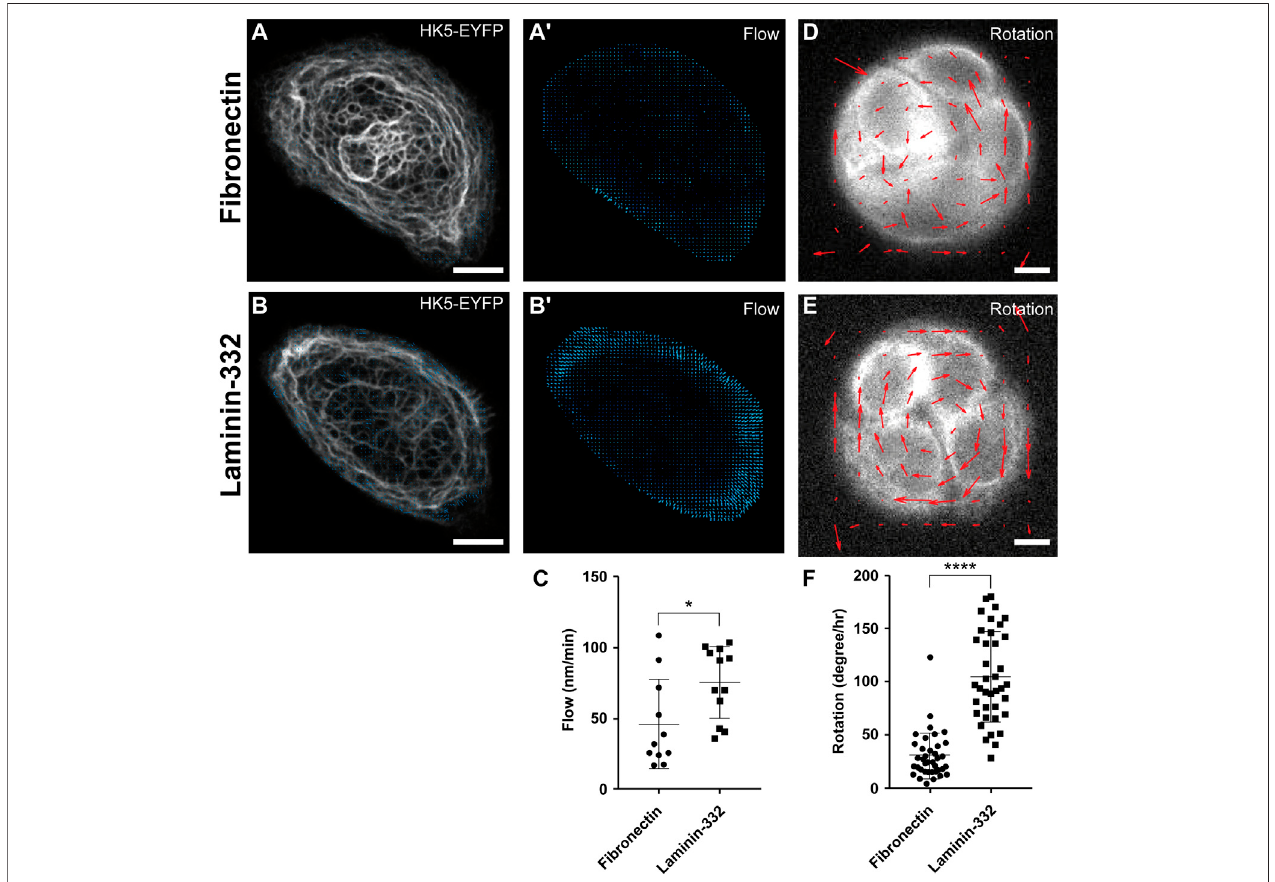
FIGURE 1 | Keratin fl ow and rotational migration of keratinocytes are dependent on ECM composition. (A,A ’ ,B,B ’ ) Show fl uorescence microscopy and corresponding keratin fl ow vectors of HaCaT B10 cells expressing EYFP-tagged human keratin 5 (HK5-EYFP) and growing on D-shaped micropatterns coated with either fi bronectin (A) or laminin-332 (B) . Live-cell images were acquired every 1 min for a duration of 30 min to measure the rate of keratin fl ow (time point 0 in (A,B) ; full sequence in Supplementary Movie 1 ). The local keratin fl ow rates are shown as blue vectors in (A ’ ,B ’ ) . (C) The dot plot depicts the results of quantitative keratin fl owrateanalysesinmultipleHaCaTB10cells.Notethatcellsgrowingonlaminin-332-coatedsurfacesexhibitsigni fi cantlyhigherratesofkeratin fl owthanthosegrowing on fi bronectin. (D,E) HaCaT B10 cells were grown on circular micropatterns and fl uorescence was recorded every 3 min for 60 min to measure rotational movement (corresponding Supplementary Movie2 ).Themean PIVsofrotatingHaCaT B10cellsgrowing on fi bronectin (D) and laminin-332 (E) werecalculatedand theresulting vectors are illustrated (red arrows) to compare the direction and magnitude of migration. Note that rotation occurred either clockwise or anticlockwise. (F) The dot plot shows that that rotation was faster in cells growing on laminin-322- than in cells growing on fi bronectin-coated surfaces. Mann-Whitney t test, n = 12, * p < 0.05, ** p < 0.01, *** p < 0.001, **** p < 0.0001. Scale bars: 10 μ m.